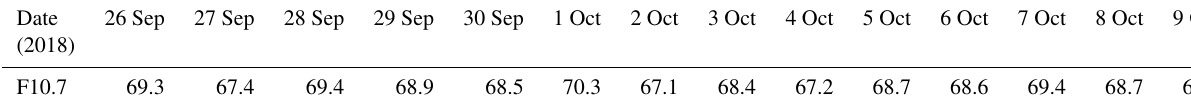
Table 2. Daily F10.7 index for the 26 September–9 October 2018 period.